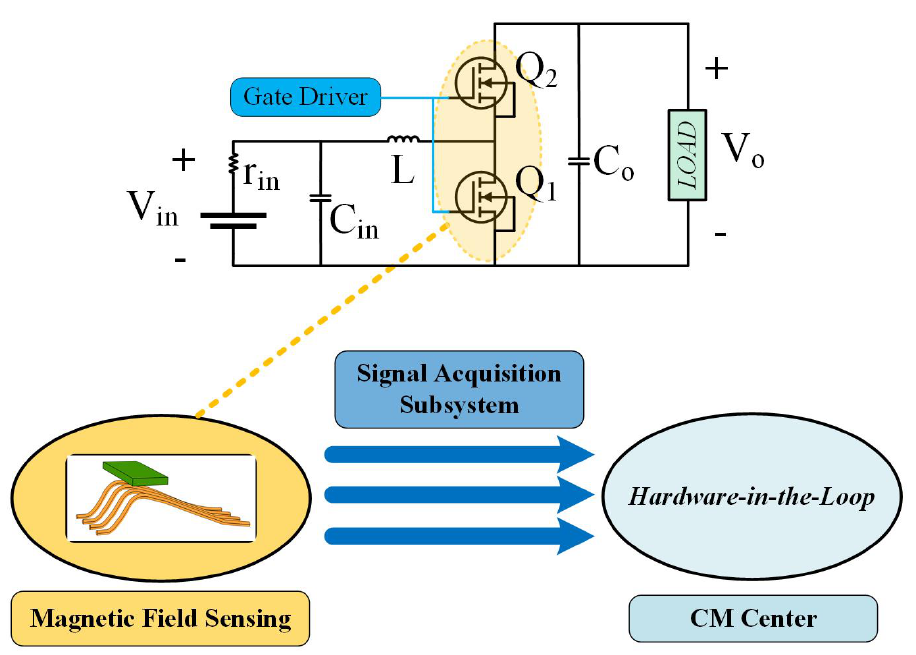
Figure 1. Proposed CM system of the SiC power